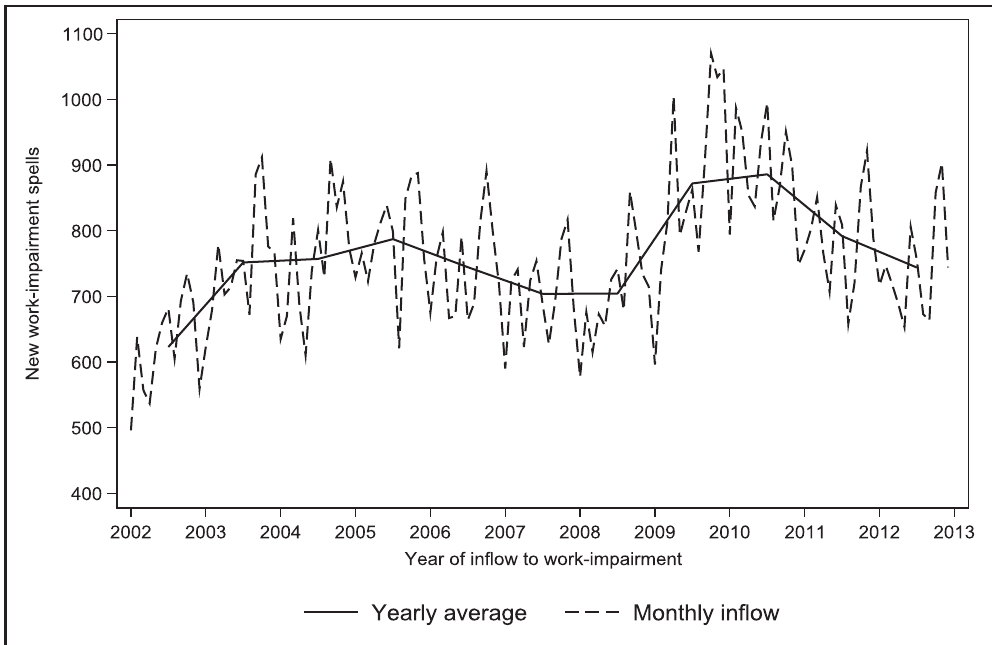
Inflow into work impairment by the month of entry. Young people 18-26 years of age in the period